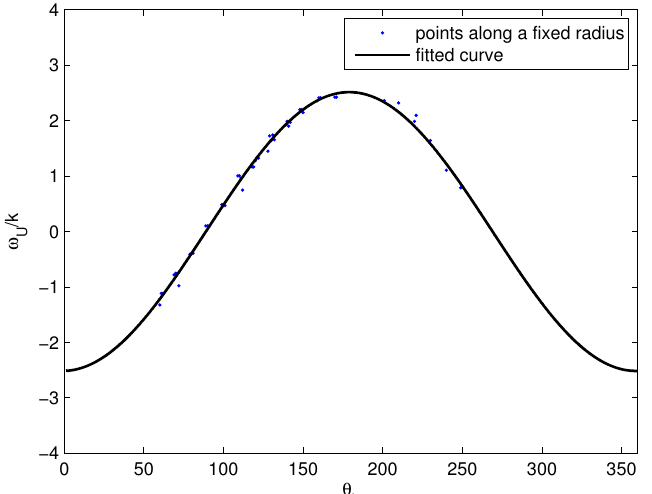
Figure 3. The curve fitting process along a particular radius. A clear sinusoidal function is estimated from the input data points, and the peak is seen to have a value close to the input current speed (2.5 m/s) and is located at 180 degrees (measured clockwise from true north), which is exactly the input current